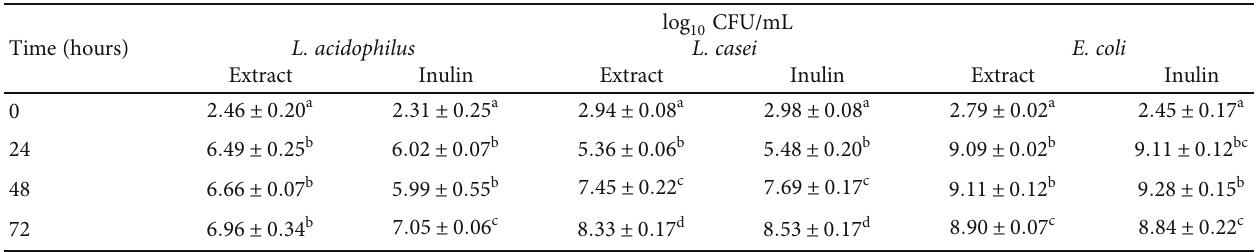
Table 10: Growth of L. acidophilus , L. casei , and E. coli in media containing A. integer extract and inulin as the sole carbon source. CFU/mL log 10 Time (hours) L. acidophilus L. casei E. coli Extract Inulin Extract Inulin Extract